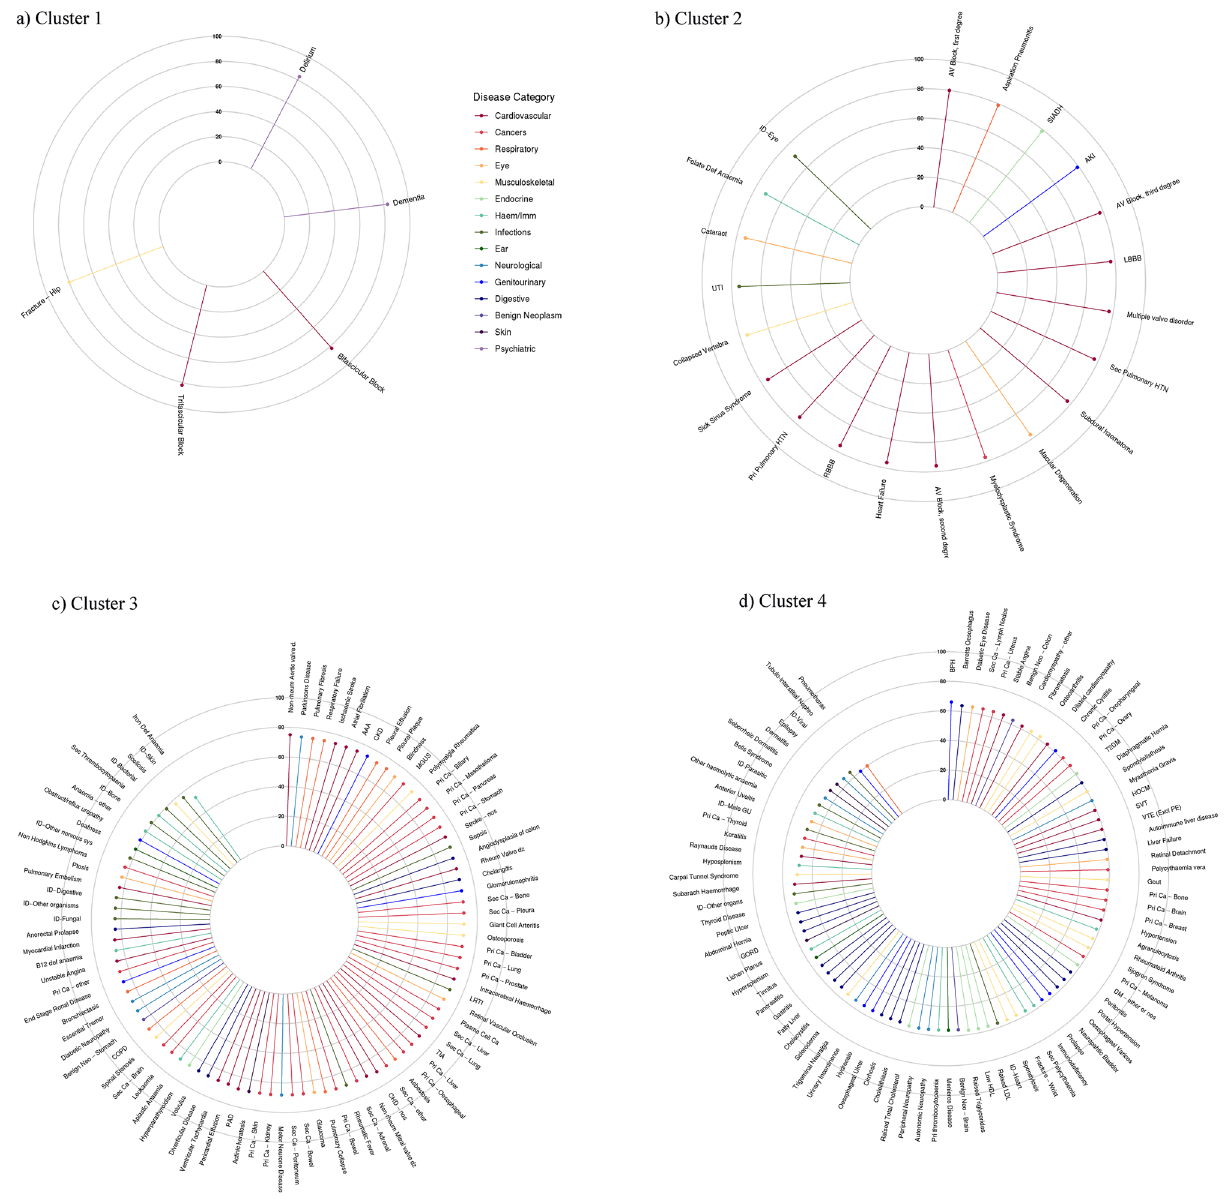
recorded diagnosis. AAA = abdominal aortic aneurysm; AKI = acute kidney injury; AV = atrioventricular; Benign Neo = benign neoplasm; CHD = coronary heart disease; CKD = chronic kidney disease; COPD = chronic obstructive pulmonary disease; DM = diabetes mellitus; dz = disease; GORD = gastroesophageal reflux disease; GU = genitourinary; HDL = high density lipoprotein cholesterol; HOCM = hypertrophic obstructive cardiomyopathy; HTN = hypertension; ID = infectious disease; LBBB = left bundle branch block; LDL = low density lipoprotein cholesterol; LRTI = lower respiratory tract infection; MGUS = monoclonal gammopathy of undetermined significance; nos = not otherwise specified; PAD = peripheral arterial disease; Pri Ca = primary cancer; RBBB = right bundle branch block; Sec Ca = secondary cancer; SIADH = syndrome of inappropriate antidiuretic hormone; SVT = supraventricular tachycardia; T2DM = type 2 diabetes; TIA = transient ischaemic attack; UTI = urinary tract infection; VTE (Excl PE) = venous thromboembolism excluding pulmonary